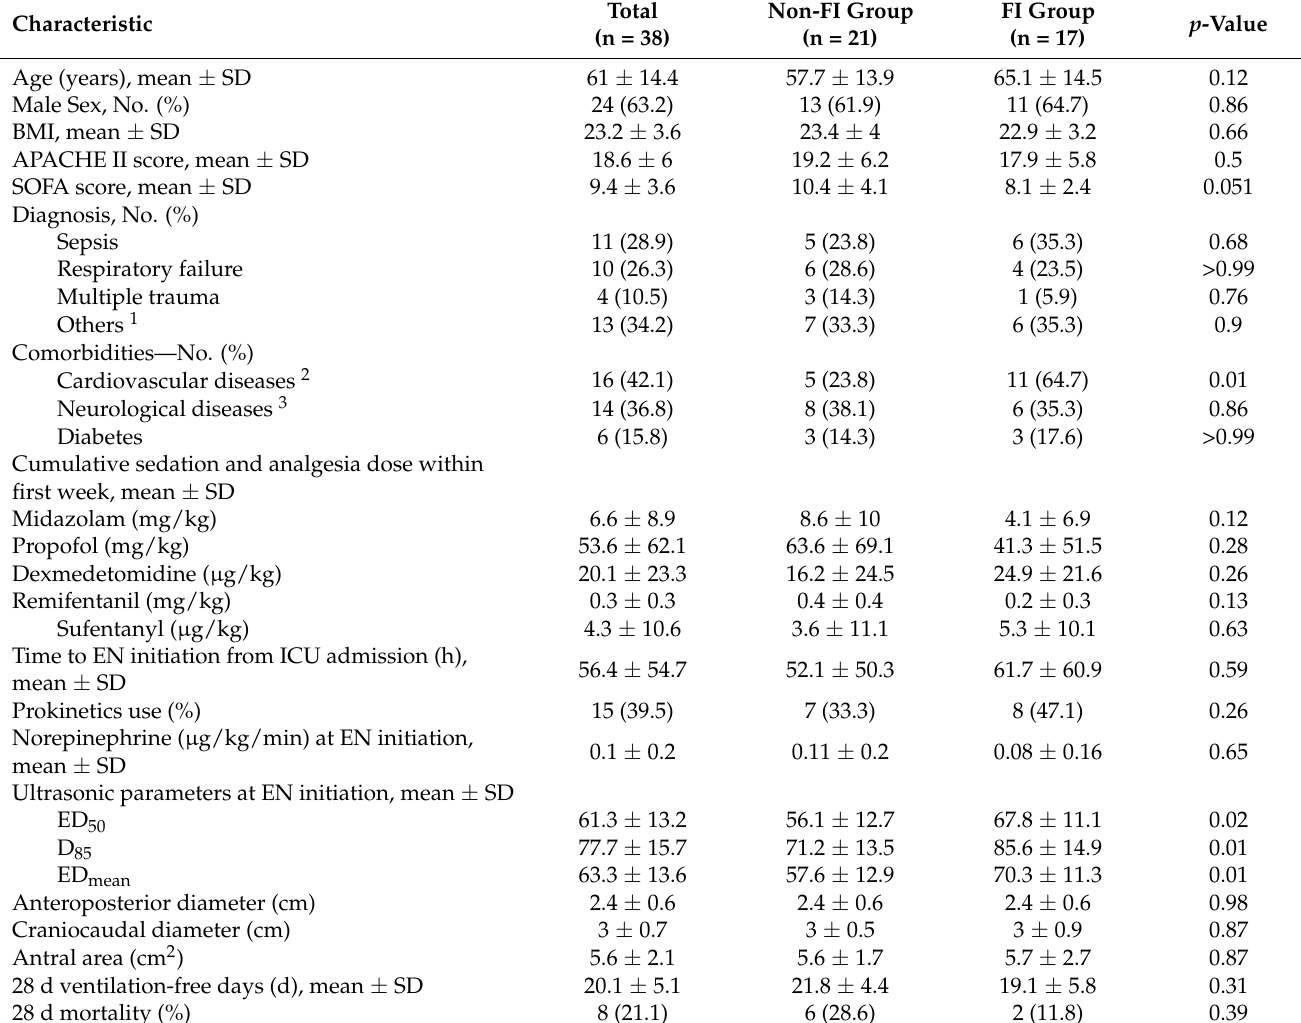
Table 3. Baseline and characteristics of patients in Non-FI and FI